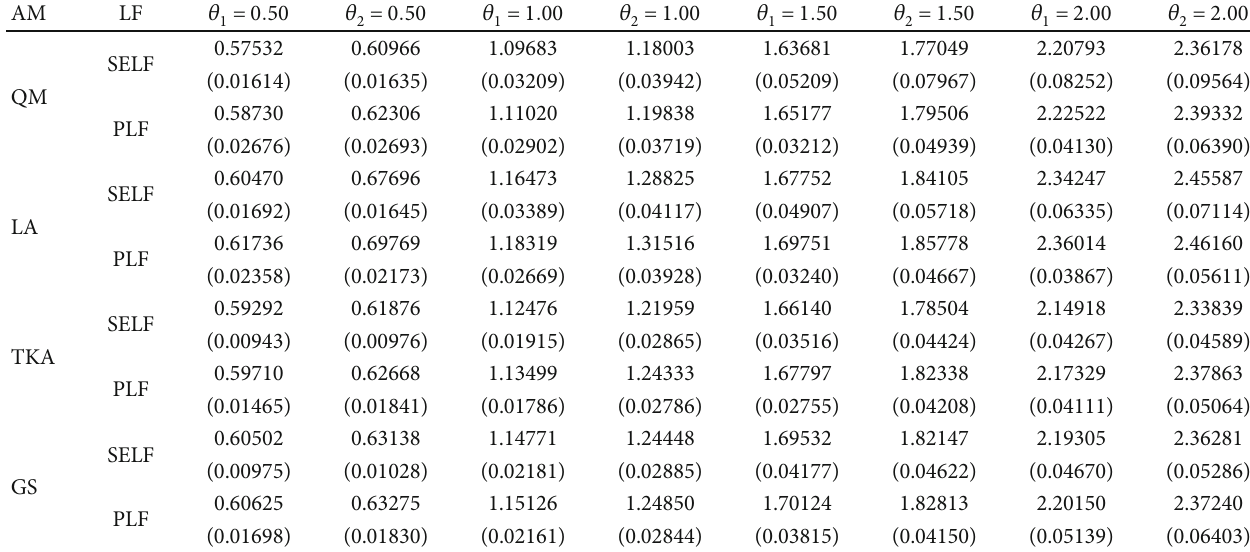
Table 3: BEs and PRs (in parentheses) under IP for n = 50